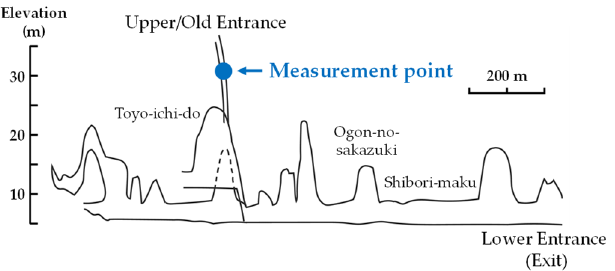
Figure 3. Profile view of Gyokusen-do Cave showing the measuring point (This figure was drawn using reference [23]). Figure 2. Map of Gyokusen-do Cave showing the measuring point and a photo of the measurement setup (This map was drawn using reference [23]).